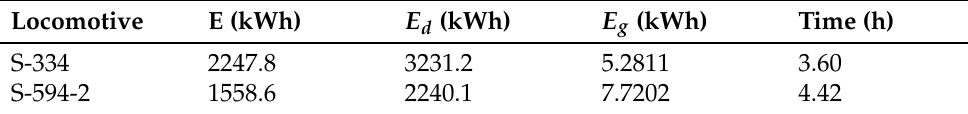
Figure 18. Power vs. distance profile, Chiriguaná–Santa Marta route. Table 4. Simulation results for the studied